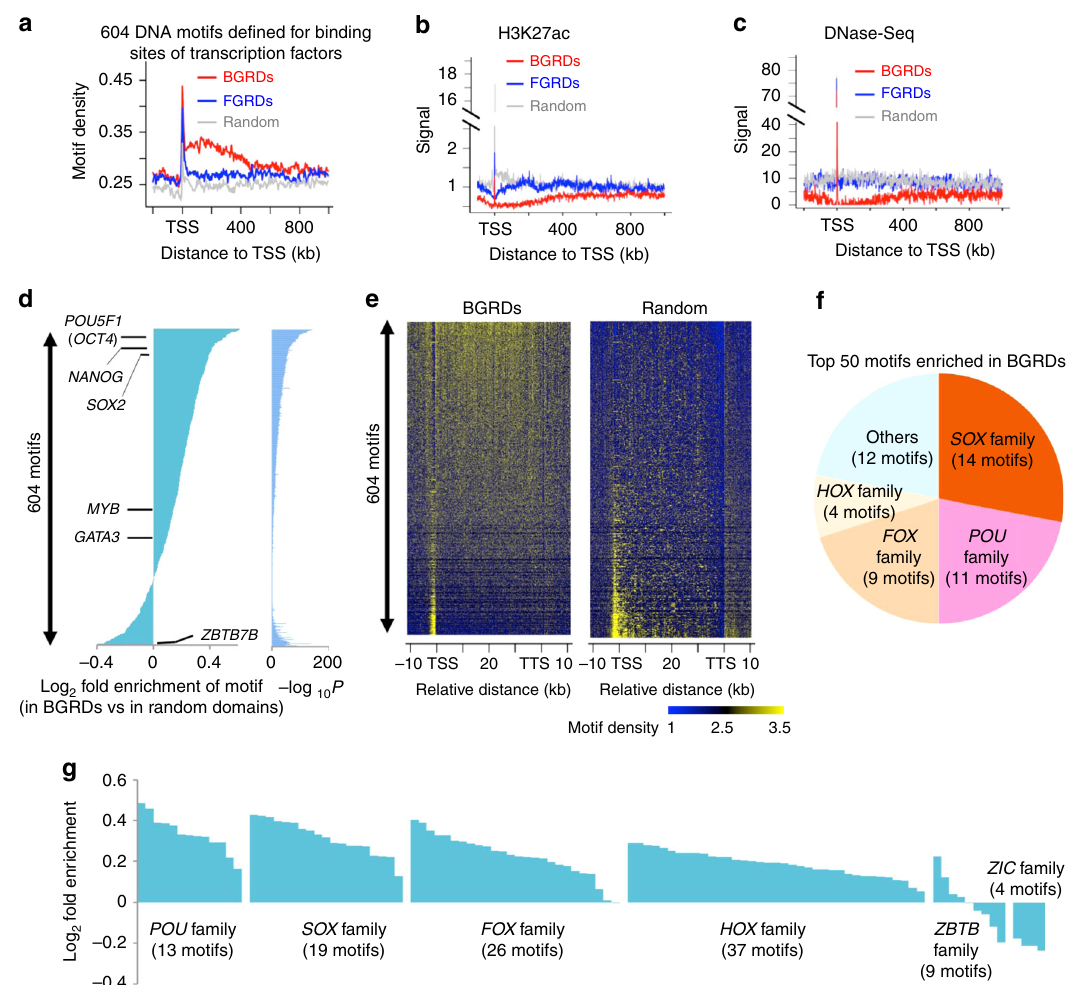
Fig. 3 BGRDs in CD4 + T cell are enriched with repressed cis -regulatory elements. Average density of 604 DNA motifs de fi ned for the binding of individual transcription factors ( a ), average signal of an epigenetic mark for active enhancers ( b ) and chromatin openness de fi ned based on DNase-Seq data ( c ) plotted around TSS associated with each category of repressive domains in CD4 + T cell. d Fold and P value enrichment of individual DNA motifs on genes associated with BGRDs relative to random control genes. Example transcription factors that bind the enriched or depleted DNA motifs were indicated. e Heatmaps to show the average density of each motif (row) at each base pair (column) around TSS of genes associated with BGRDs (left) and random domains (right). Motifs were ranked as in d . f Pie chart to show transcription factor families associated with 50 DNA motifs that are most enriched in BGRD genes relative to random control genes. g Fold enrichment of each DNA motif on genes associated with BGRDs relative to random control genes, with the DNA motifs for six transcription factor families presented. P values determined by one tail Wilcoxon test d . Source data are provided as a Source Data fi (Fig. 4d, e). The majority (81.4%) of the 500 most conserved BGRDs were shared between the ENCODE and Roadmap sam- ples (Fig. 4f).